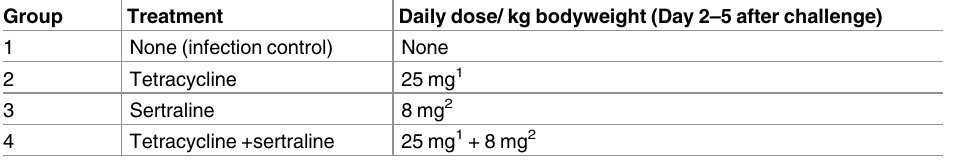
Table 1. Overview of experimental groups. Each group consisted of 10 commercially brown layers, 45 weeks of age.